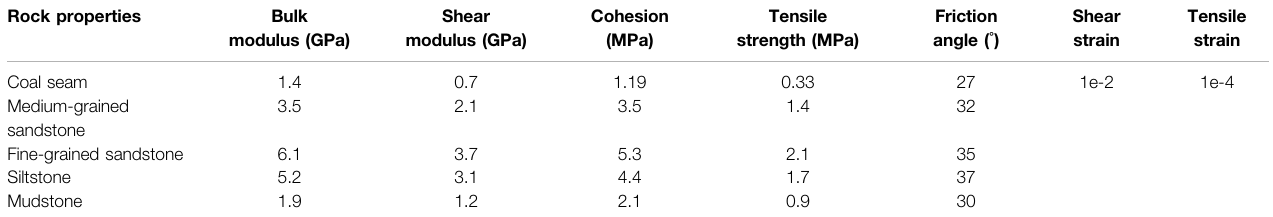
TABLE 1 | Mechanical properties for No. 18401 Panel numerical model.